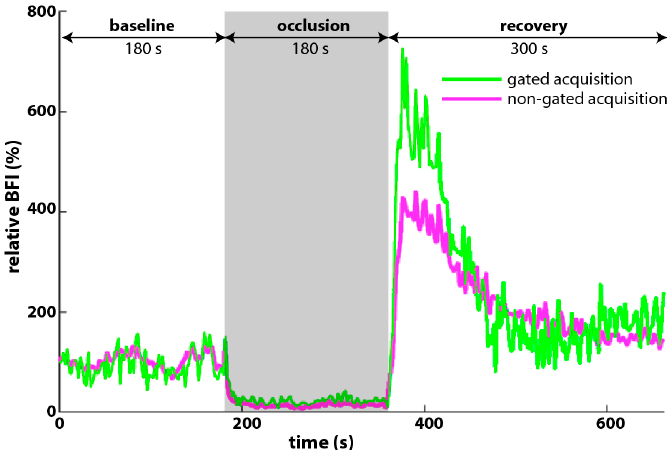
Figure 16. Relative blood flow index (BFI) during an arterial cuff occlusion recovered from the hardware correlator for both non-gated acquisition and gated one (figure generated with data taken from Ref. [155]).